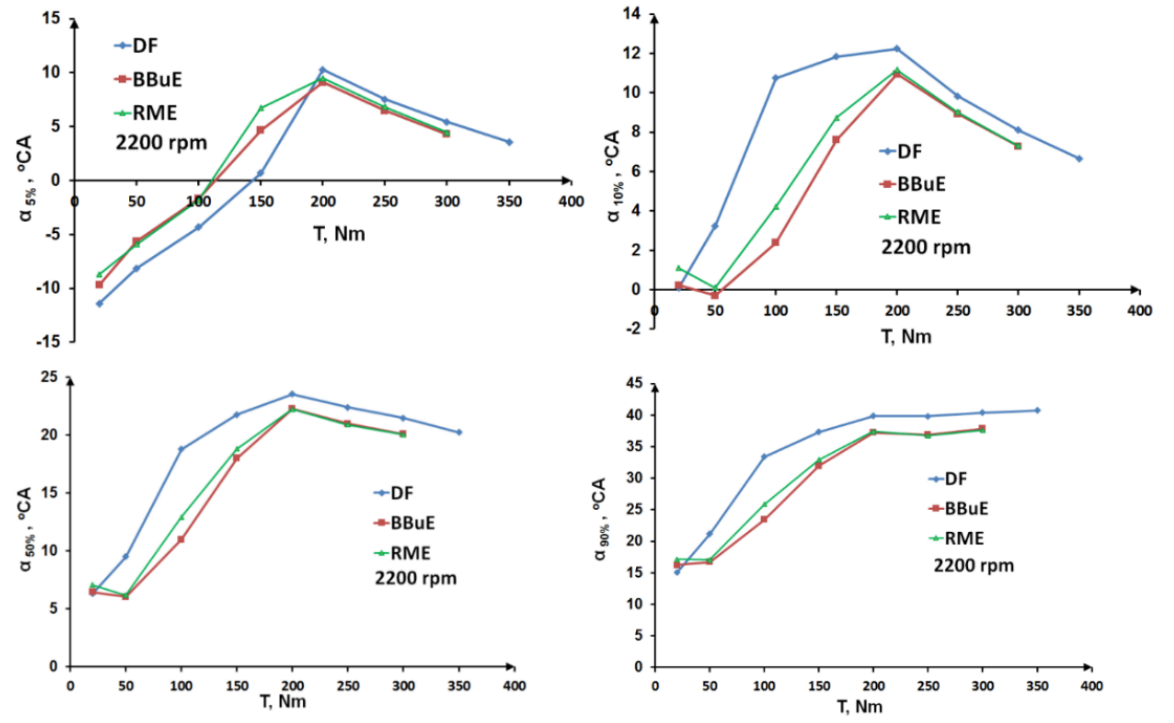
Figure 17. Angular values of crankshaft rotation of the engine at which 5, 10, 50 and 90% of the fuel dose was burned.